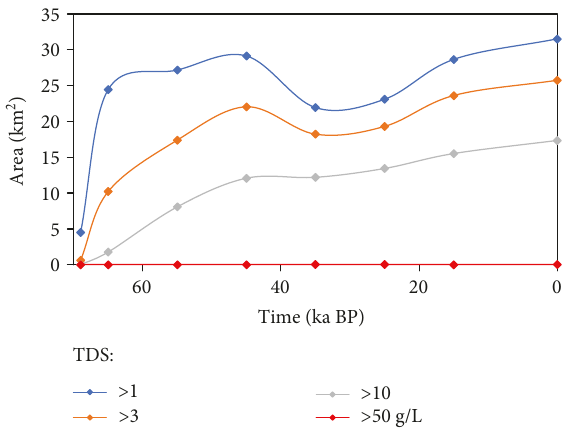
Figure 9: Areas of high TDS in di ff erent